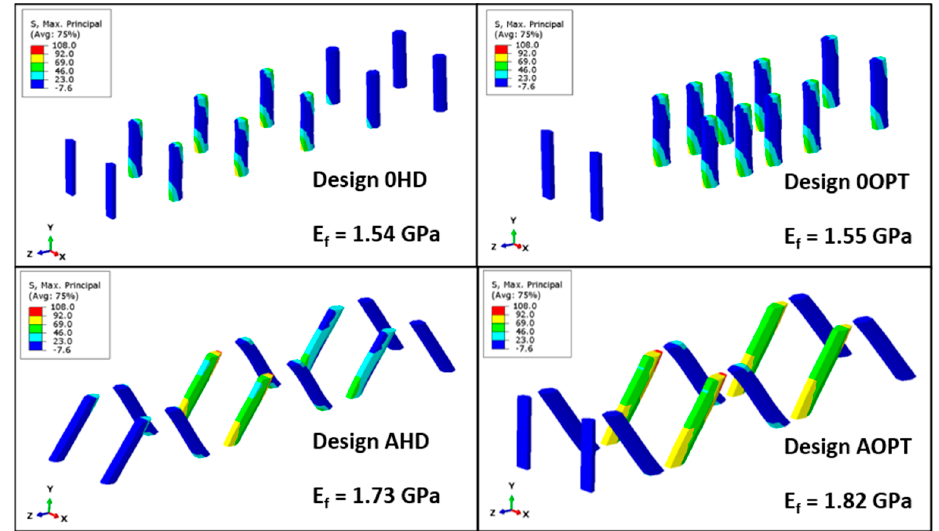
Figure 5. Maximum principal stress in pins of selected designs on the simplex optimization process for displacement of 10 mm. for displacement of 10 mm.